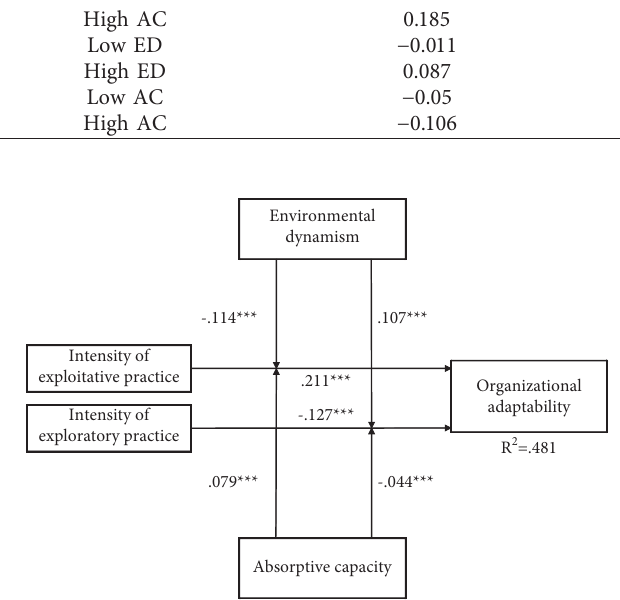
Figure 7: Result of MRA for the research model.